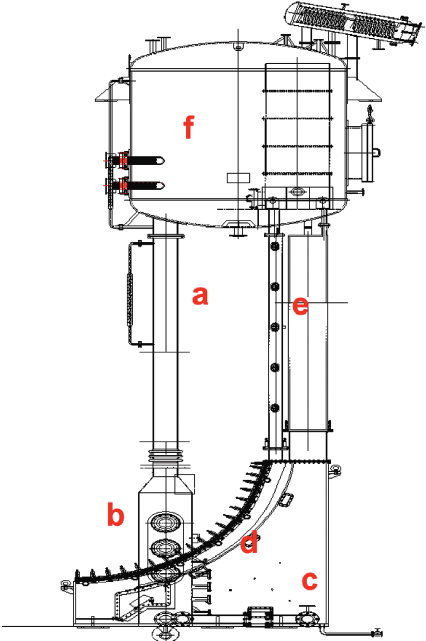
Figure 3: Natural circulation loop of CHF experiments, where a is the downward pipe, b is the inlet water chamber, c is the downward water tank, d is the flow passage heated by heat section, e is the upward pipe, and f is the upward water tank.